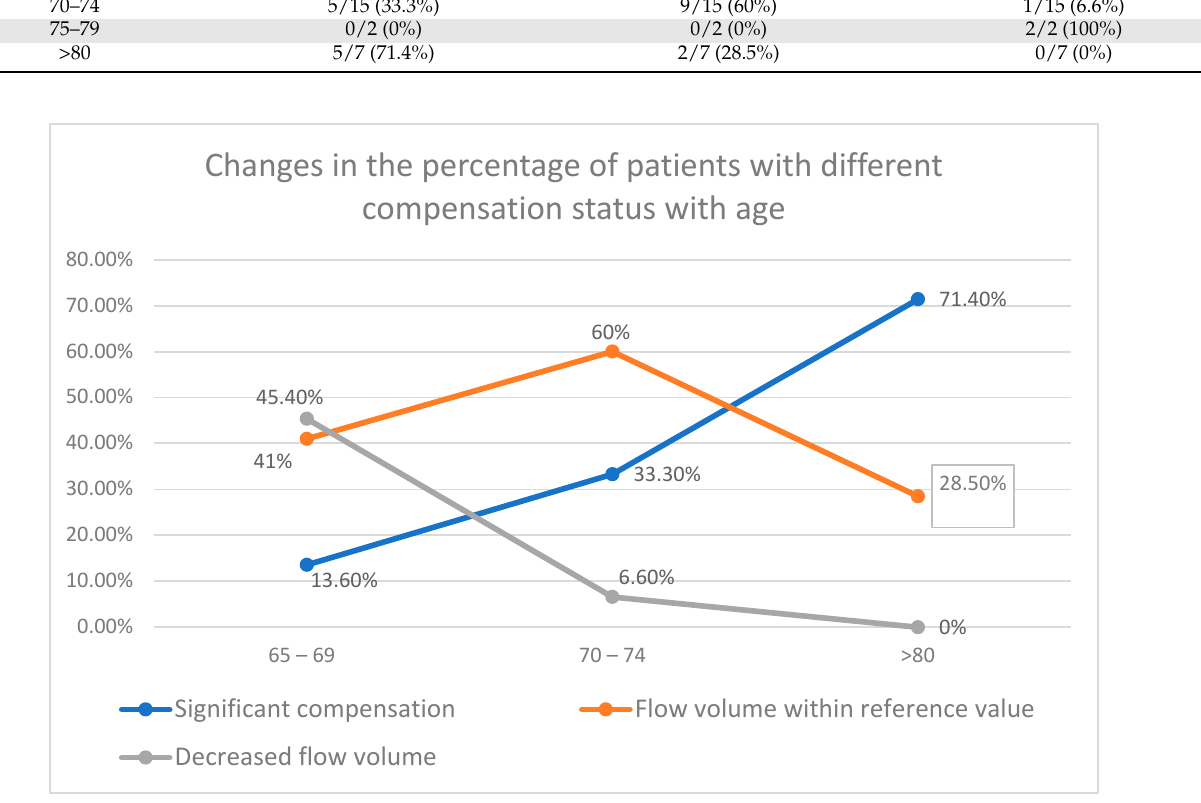
Figure 1. Tendencies in CBF changes in different age groups. The percentage of patients with significant flow compensation tends to rise with increasing age. The opposite trend is observed in the group with decreased flow volume. The age 75–79 group was excluded from the analysis.